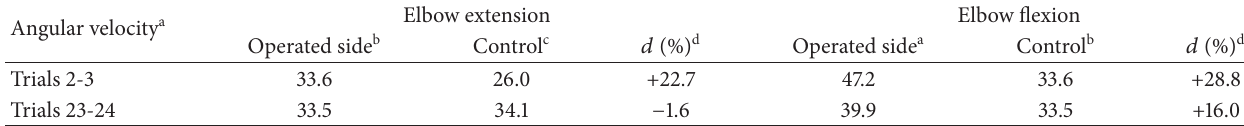
Table 2: Elbow extension-flexion endurance (Nm)